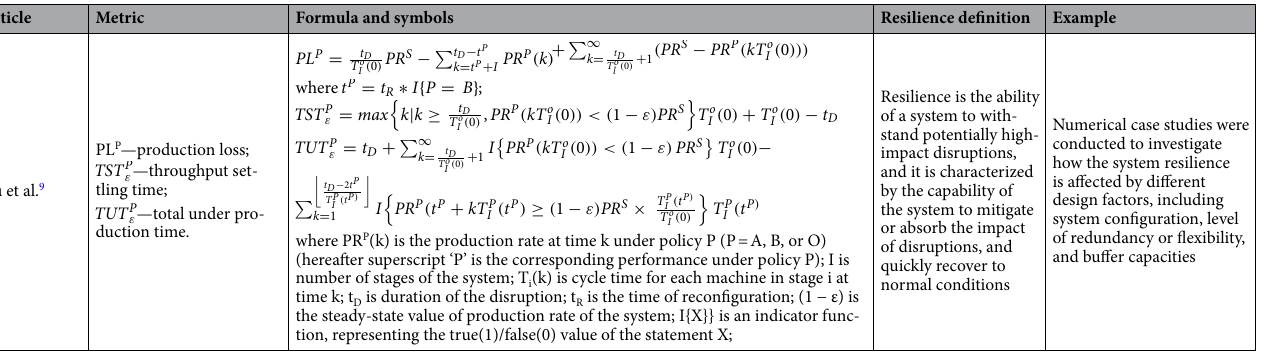
Table 6. Comparison of resilience metrics based on mathematical formulas, resilience definitions and application examples.